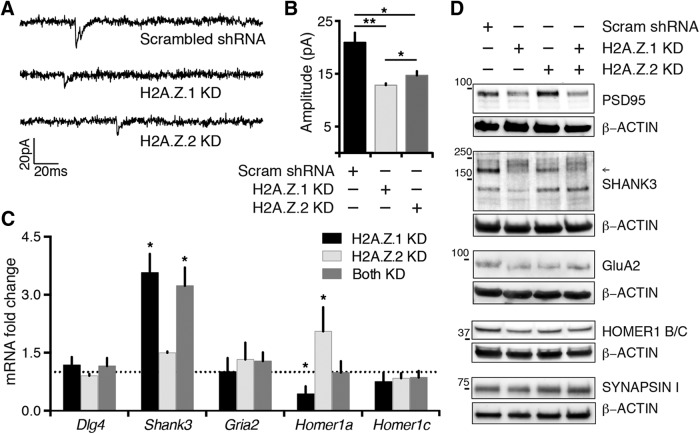
H2A.Z hypervariant-specific RNAi has synaptic effects. A, B, Amplitude of mEPSCs decrease after H2A.Z.1 or H2A.Z.2 depletion. Shown are example traces in A with quantification of mEPSC amplitude is in B (N = 3; n = 15 neurons for Sc, 10 for H2A.Z.1 KD, and 8 for H2A.Z.2 KD; *p < 0.05 and **p < 0.001). Neurons were infected for 5–7 d. C, mRNA levels of indicated genes, normalized to Gapdh, represented as fold change of their abundance in control neurons (broken line at 1 on y-axis). N = 3–5. *p < 0.05. D, Representative Western blottings of synaptic fraction from control or H2A.Z hypervariant-depleted neurons as indicated. Loading control (β-ACTIN) for individual blots are provided and molecular weights of the nearest protein ladder band is indicated. Arrow indicates quantified SHANK3 band (see text). Neurons were infected for 7 d. N = 3. Note: levels of synapsin, a presynaptic molecule, remain unaltered after hypervariant depletions.